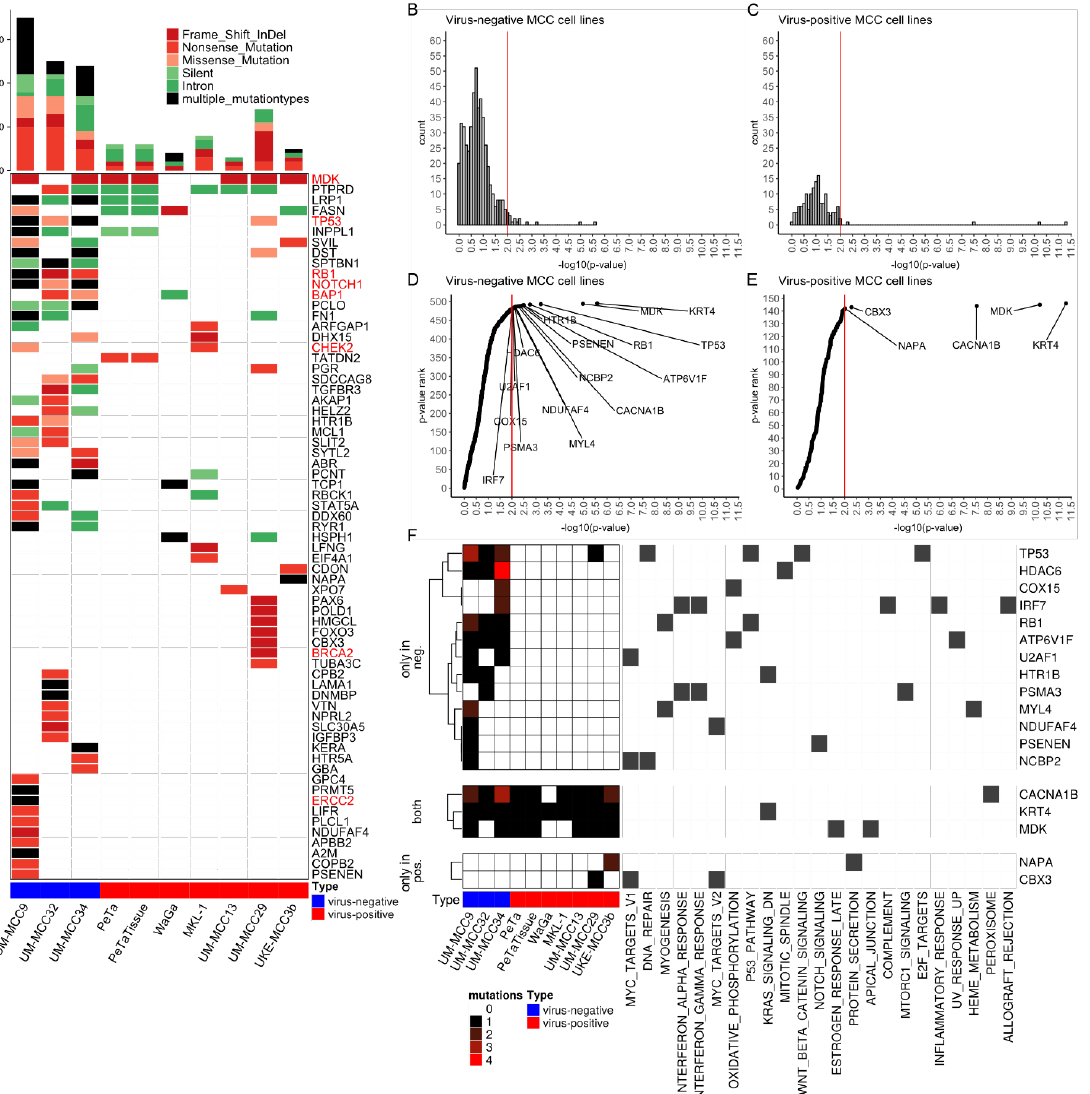
Figure 3. Virus-negative MCC cell lines have high number of coding mutations altering protein structure and significantly mutated genes. ( A ) Oncoplot showing genes selected by the following criteria: (i) containing either a frameshift InDel, nonsense or nonstop mutation and (ii) it is either within a Hallmark Gene Set or its mutation is annotated as pathogenic in ClinVar database. The number of mutations within the selected genes are depicted as bar chart. Both plots are colored by variant classification. Genes emphasized in red are discussed in the results section; ( B – E ) Distribution of p -values for identification of SMGs as histogram ( B , C ) and ranked by p -value ( D , E ) for virus-negative ( B , D ) and -positive ( C , E ) MCC cell lines; only genes present in Hallmark Gene Sets were taken into account, red lines indicate a p -value of 0.01, genes with a p -value of exactly 1 are not shown; ( F ) Mutational burden and involvement in biological processes of SMGs with p -value below 0.01 and presence in Hallmark Gene Sets. Abbreviations: MCC: Merkel cell carcinoma, InDel: Insertion and deletion, SMG: Significantly mutated